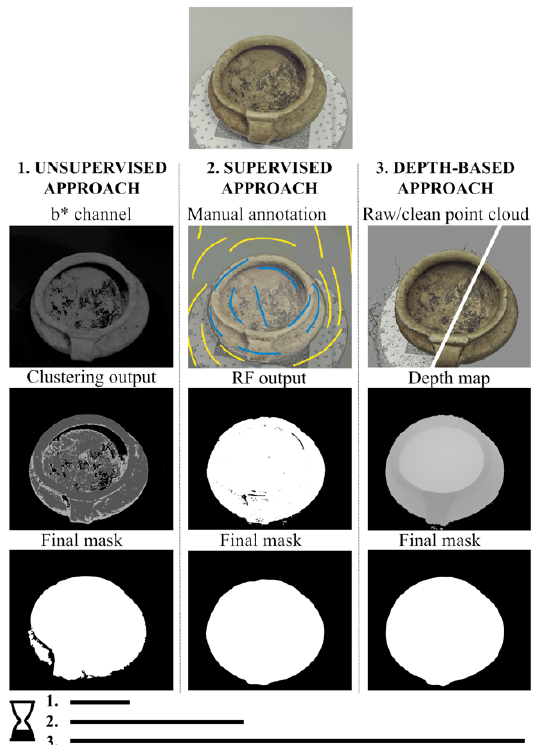
Figure 6. The proposed automated solutions to mask unwanted object's backgrounds. The respective processing times is also reported.